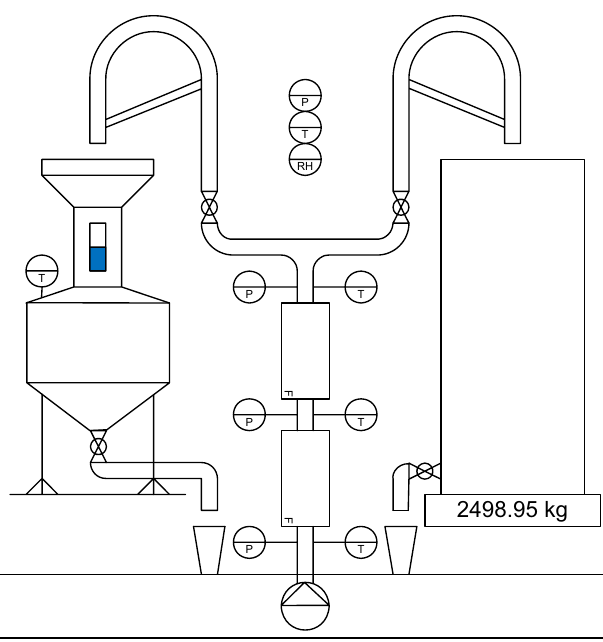
Fig. 3. Schematic calibration